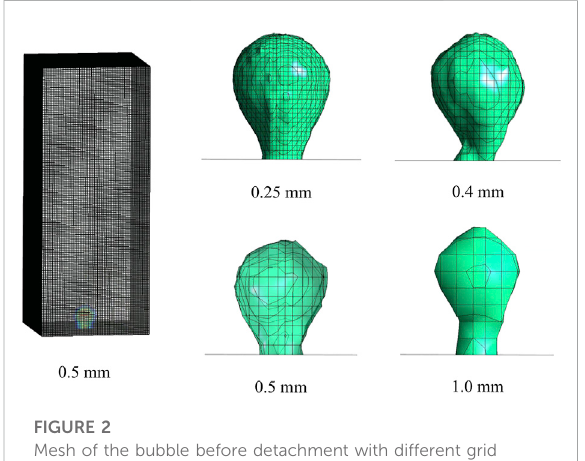
FIGURE 2 Mesh of the bubble before detachment with different grid sizes.